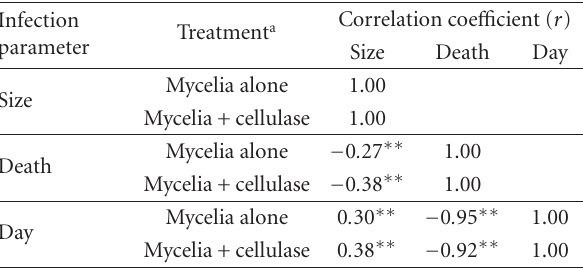
Table 1: Correlation coe ffi cients ( r ) across two fungal treatments of Orobanche aegyptiaca tubercle size, death, and days to